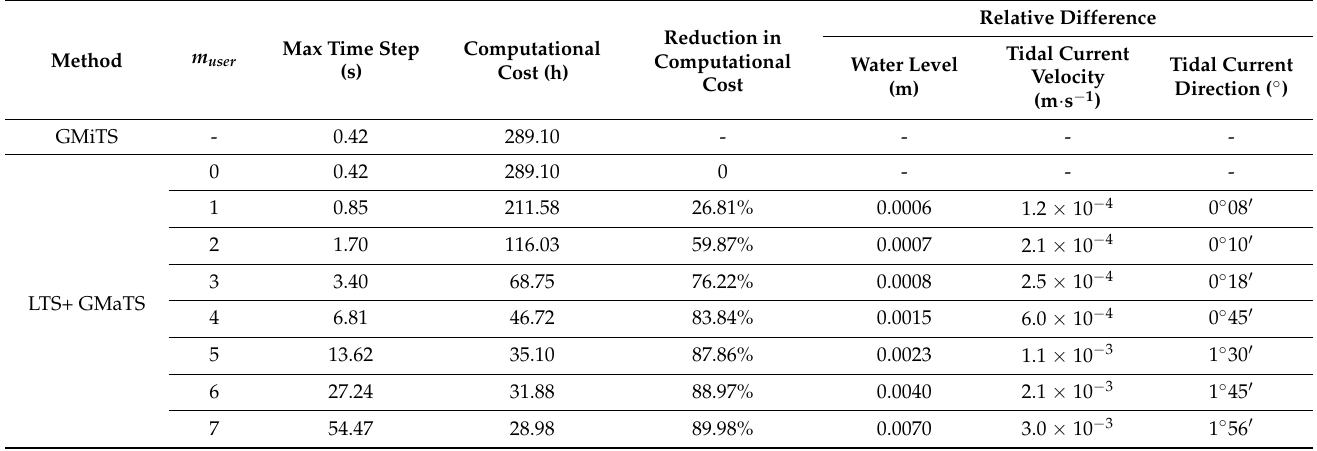
Table 2. The calculation time and relative difference of different